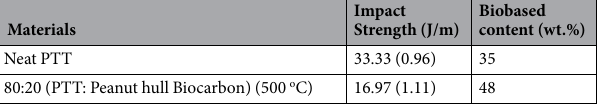
Table 9. Mechanical properties of neat PTT and peanut hull biocarbon composites.